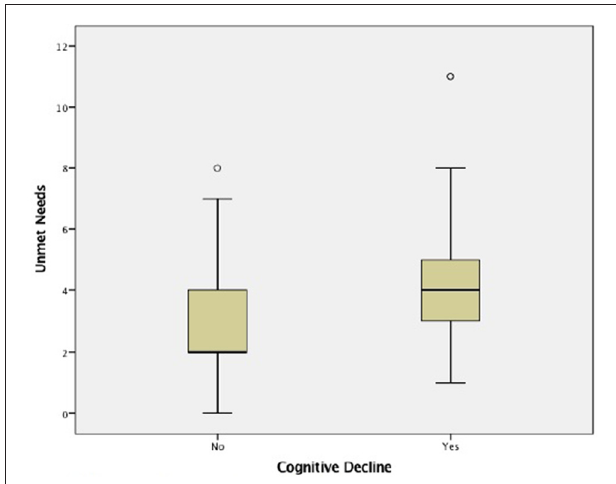
FIGURE 1 | Unmet needs considering cognitive decline .